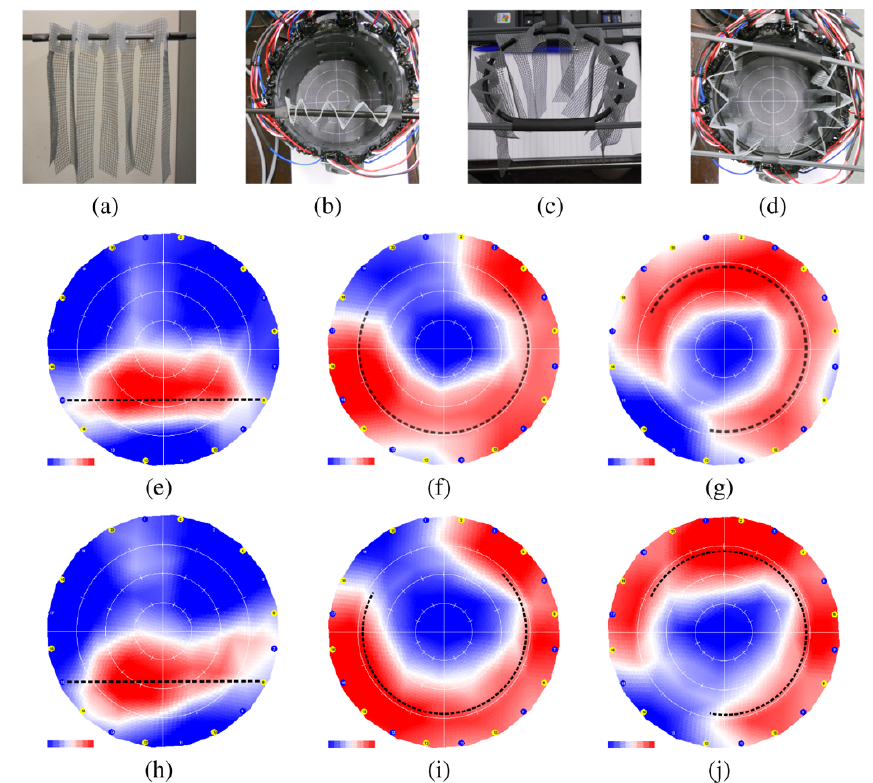
Figure 5. Dry test results of the optical tomography device. (a) Linear wire mesh curtain used to represent a particle cloud; (b) positioning of the linear curtain; (c) curved wire mesh curtain; (d) positioning of the curved curtain; (e) inversion result for linear curtain (single beam path); (f, g) inversion results for curved curtain (single beam path), (h) inversion result for linear curtain (multiple beam paths); (i, j) inversion results for curved curtain (multiple beam paths). A dashed line indicates the actual position of the curtain in (e–g)